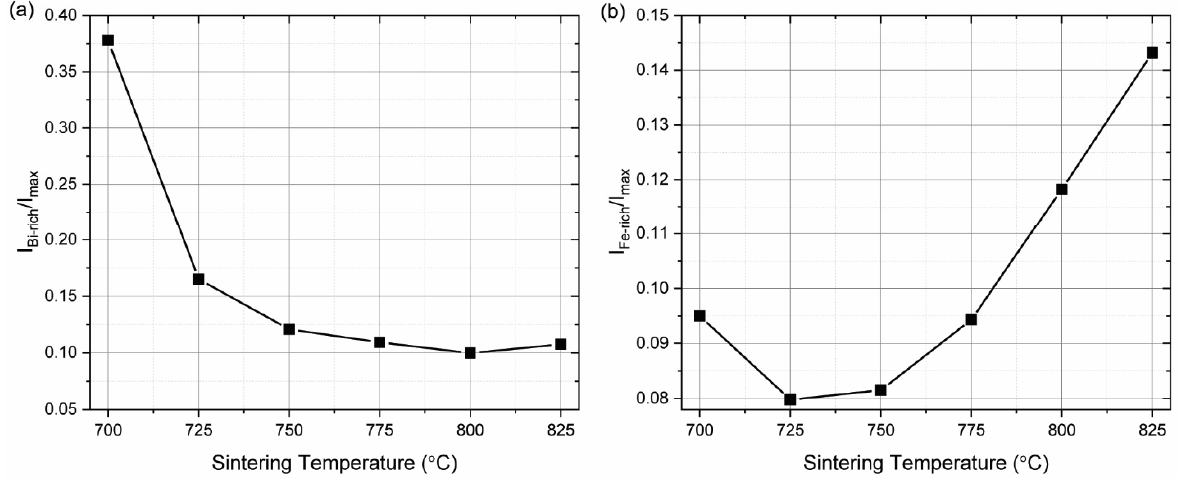
Figure 2. Comparison of intensities of secondary phases with the major peaks of bismuth ferrite for sample produced with stoichiometric precursors (( a ) Bi 25 FeO 39 , ( b ) Bi 2 Fe 4 O 9 ).